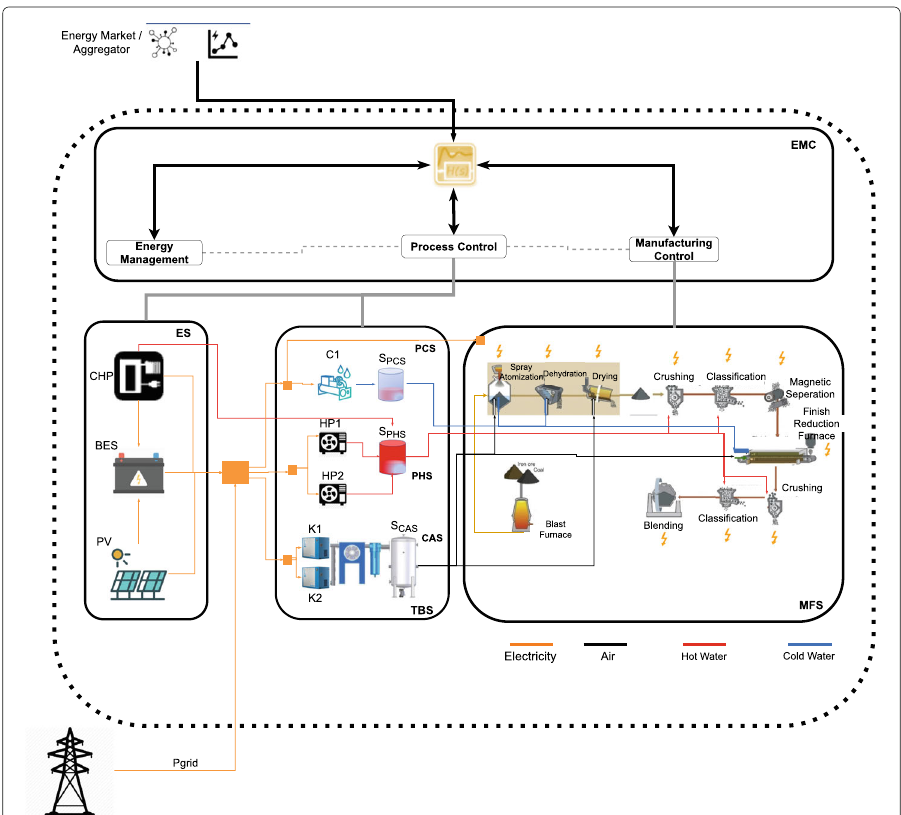
Fig. 4 Overall representation of the exemplary industrial process as divided by MFS; TBS; ES. Process layout and pictures for MFS taken from Yu et al. (2016)